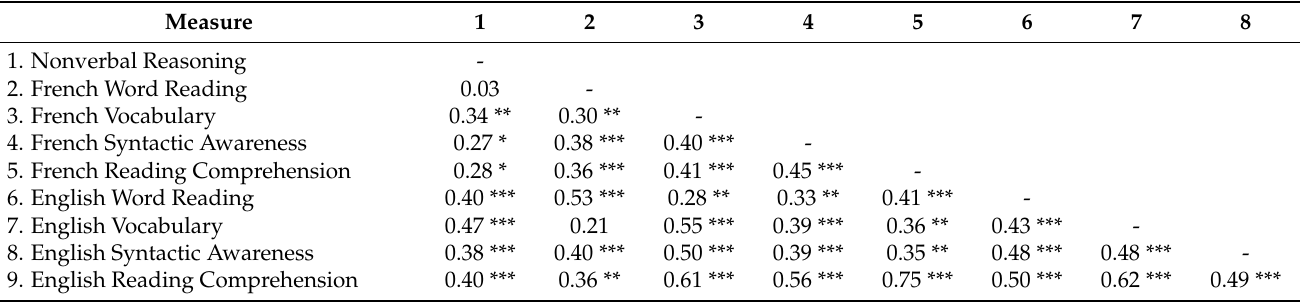
Table 2. Pearson Correlations Among All Measures (n = 72).